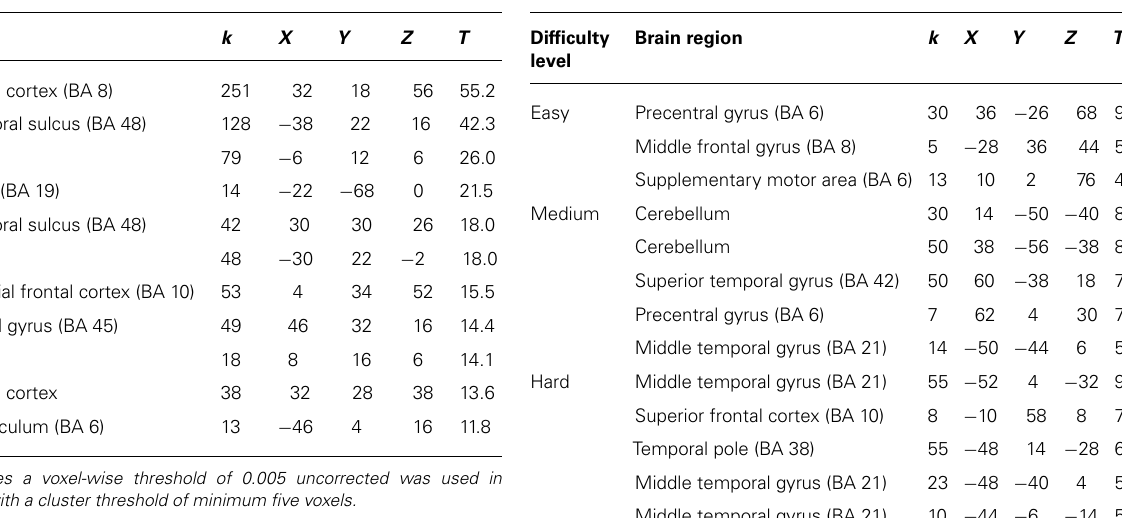
Table 2 | Brain regions and local maxima of clusters, recruited by novices during action decision of successful trials compared to unsuccessful trials.